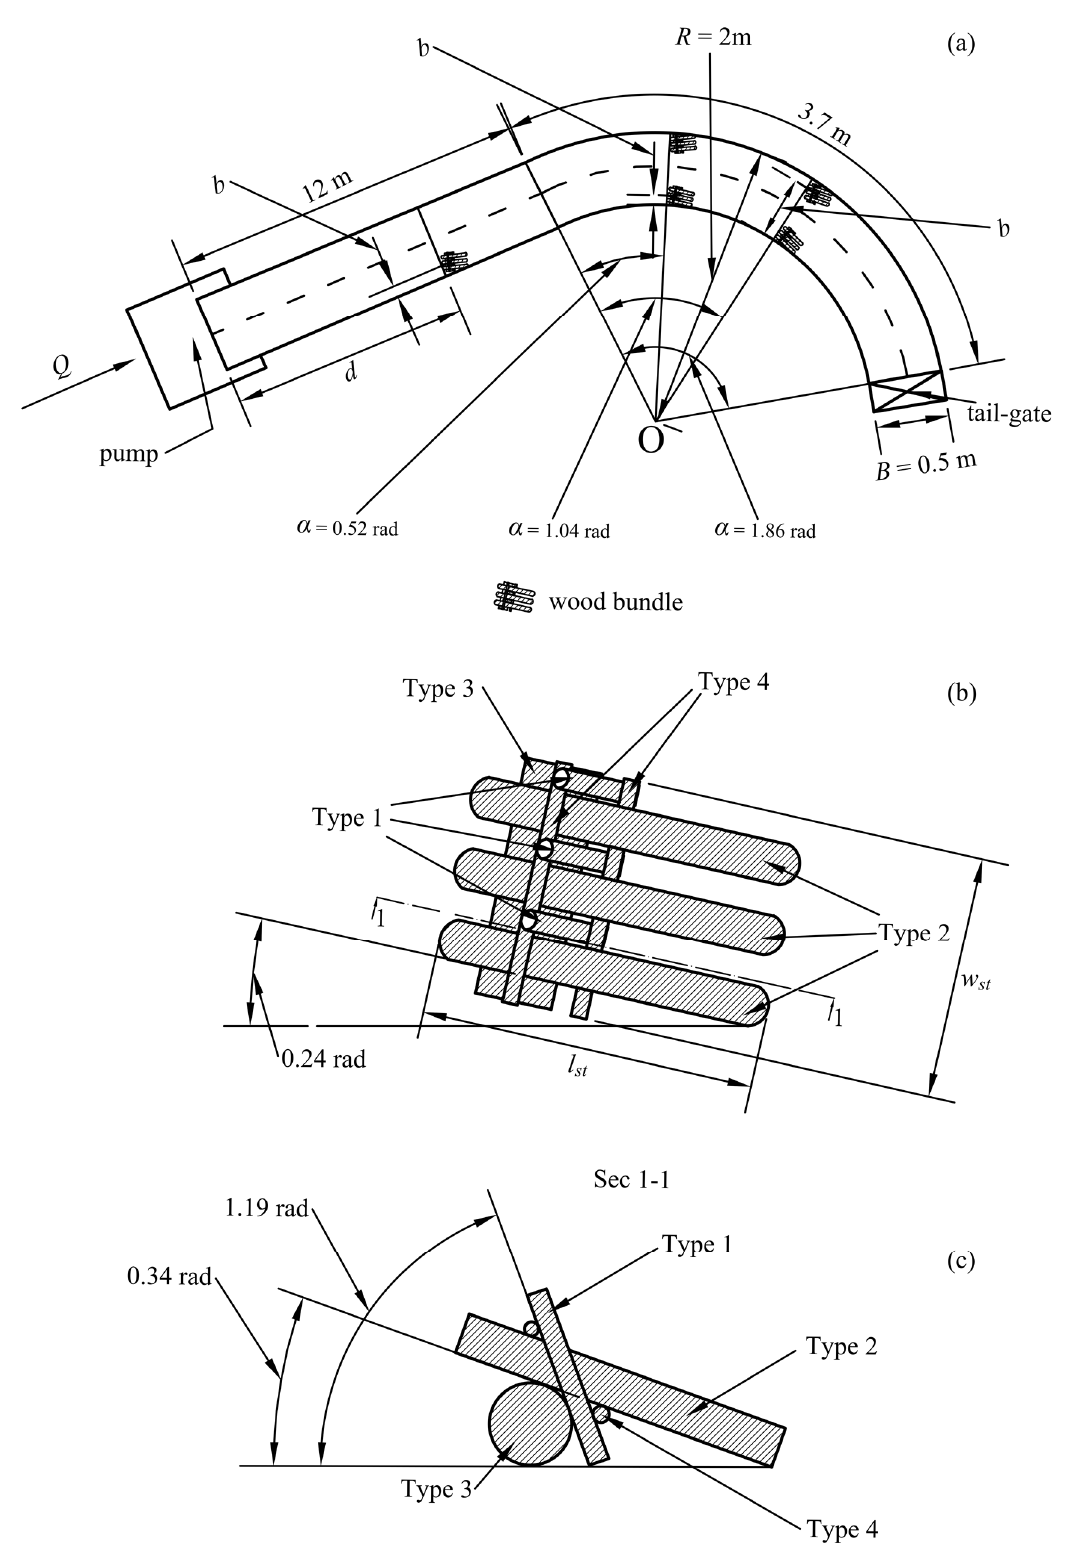
Figure 1. ( a ) Experimental channel showing longitudinal and transversal wood bundle positions in straight and curved channel. ( b , c ) Plan and side views of the individual wood bundle structure adopted in the study. Thereafter, the same tests were repeated with structure series containing two or three structures, with n denoting the number of structures in a series arrangement.